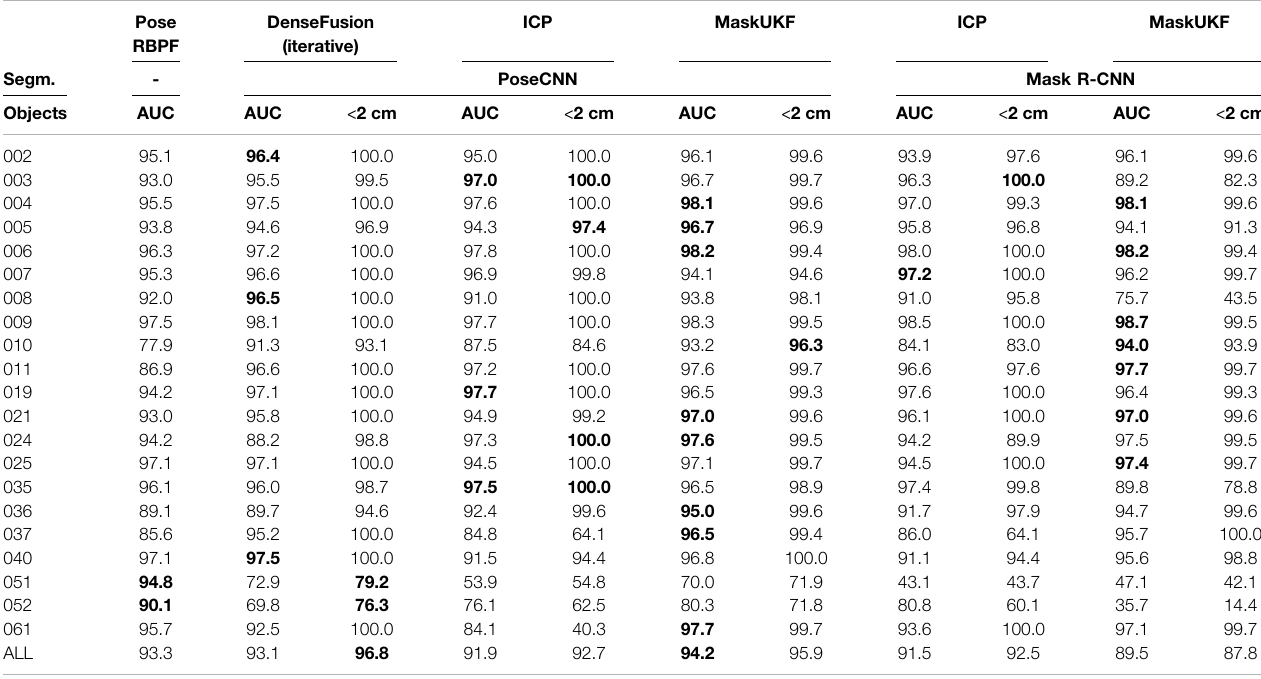
TABLE 1| Quantitative evaluation of6D poseonYCB-VideoDataset key-frames (ADD-S).We do notreportADD-S < 2 cmfor PoseRBPF asthisinformationisnot available intheoriginalpaper.Inthisexperiment, segmentationmasksareavailableateach frame I t .Aboldentryindicatesastrictly betterresult(i.e.ifdifferentalgorithmshavethe same best result, the associated entries are not